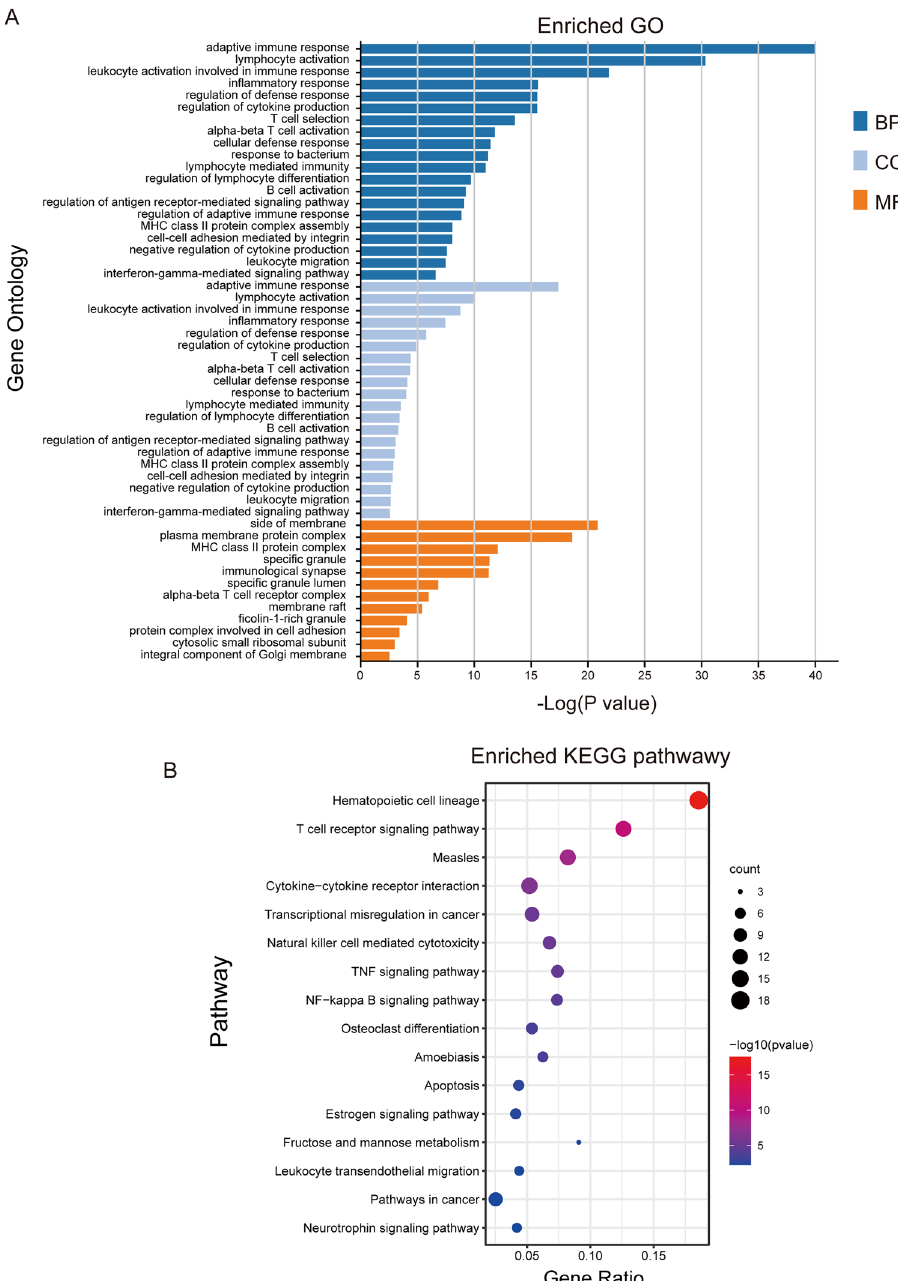
Figure 10. Enrichment analyses of the 297 DEGs. BP, MF, CC ( A ), and KEGG pathways ( B ) of the PPI were